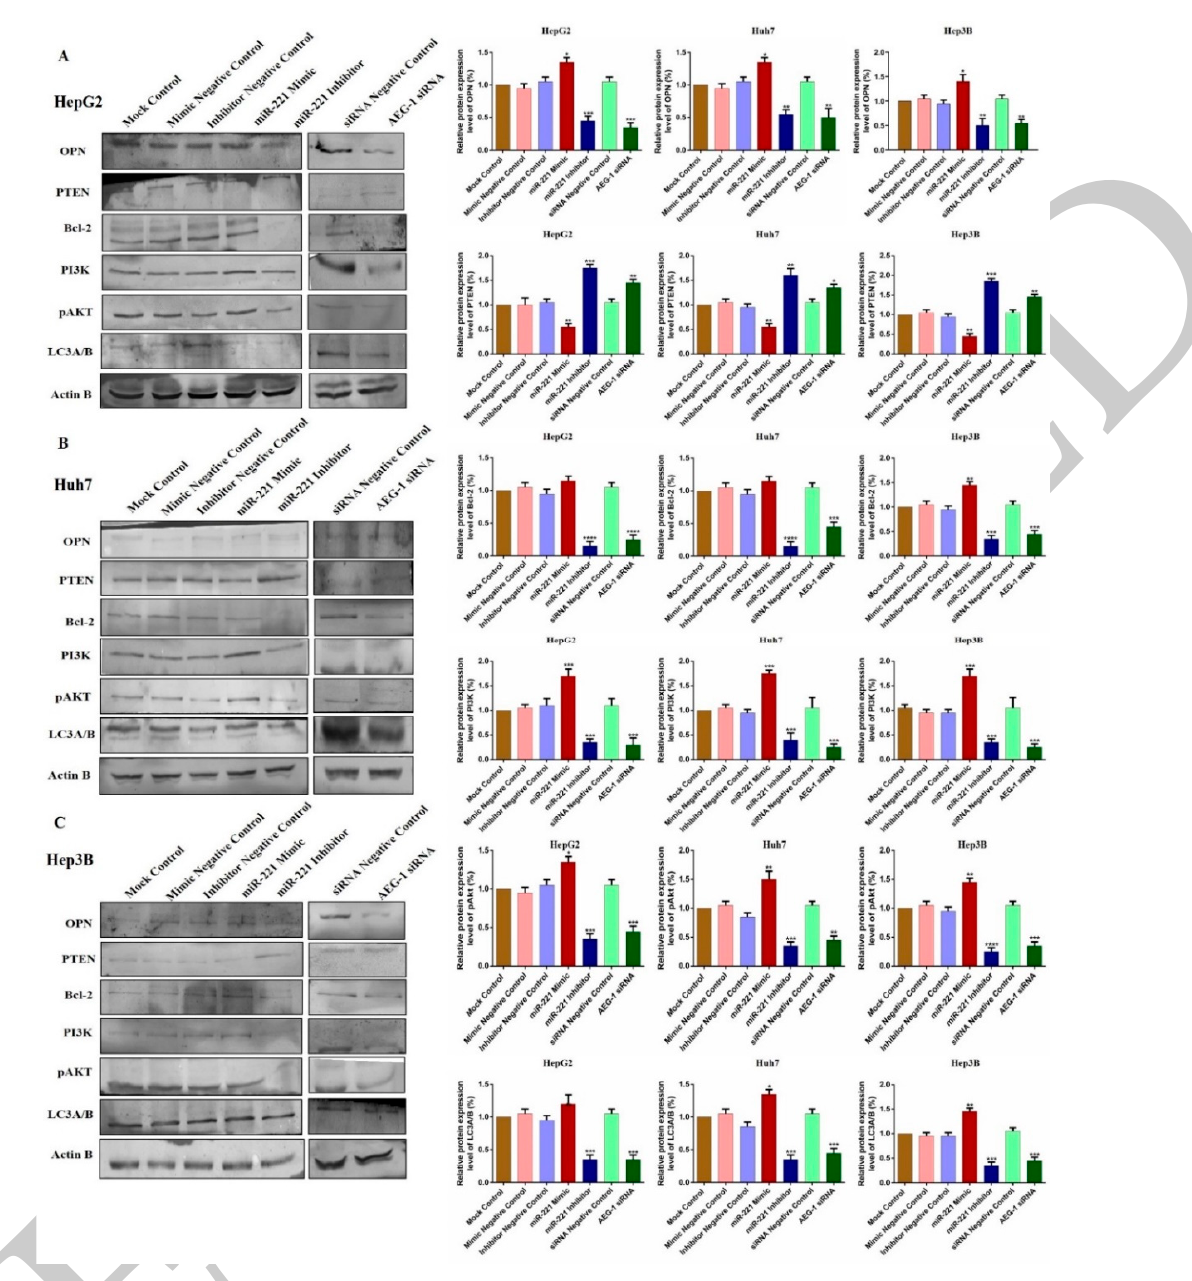
Figure 8. Knockdown of miR-221 / AEG-1 modulates apoptosis and autophagy regulatory proteins